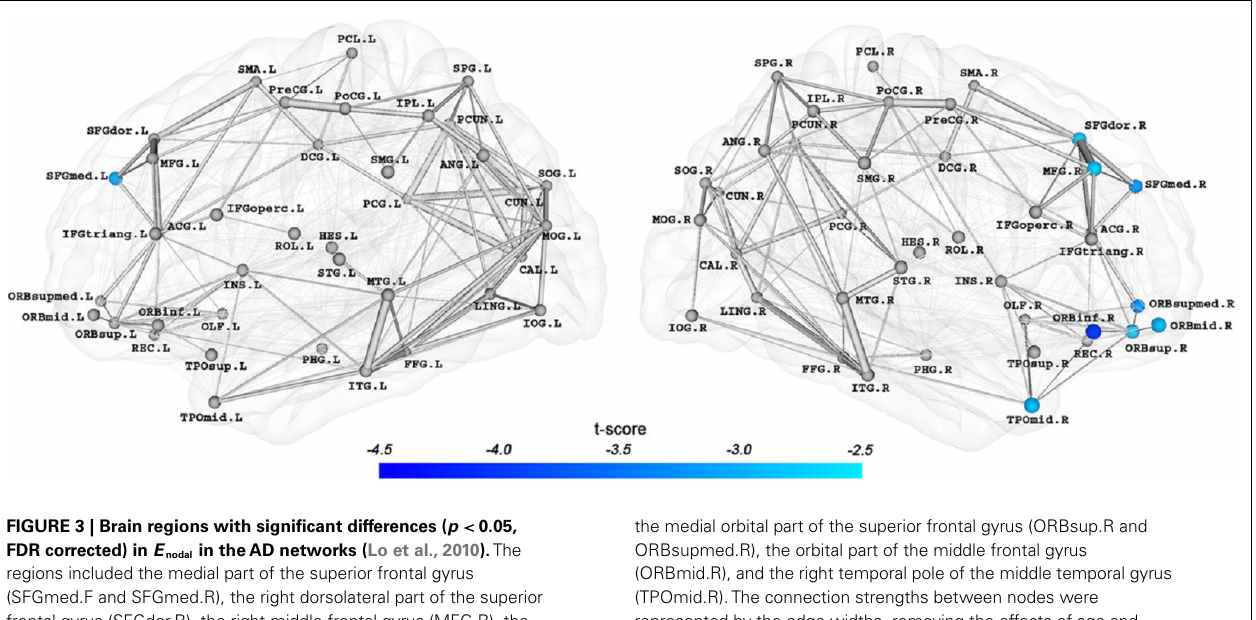
FIGURE 3 | Brain regions with significant differences ( p < 0.05, FDR corrected) in E nodal in theAD networks (Lo et al., 2010). The regions included the medial part of the superior frontal gyrus (SFGmed.F and SFGmed.R), the right dorsolateral part of the superior frontal gyrus (SFGdor.R), the right middle frontal gyrus (MFG.R), the right orbital part of the inferior frontal gyrus (ORBinf.R), the orbital and